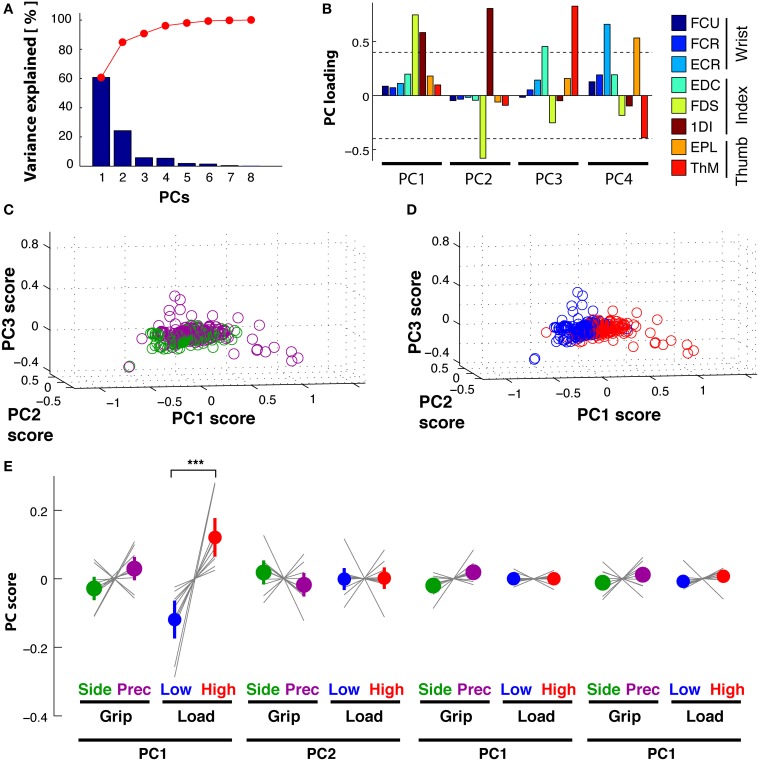
Hold period: PCA on EMG. (A) Scree plot: percentage of explained variance in the EMGs by each PC (blue bar, Eigenvalue in %) and cumulative percentage explained (red). (B) Loadings for each EMG (color-coded) per PC. (C) PC space formed by the first three PCs: each trial is represented by its PC scores. No visible separation between PC scores of side grip (green) vs. precision grip trials (purple). (D) PC space of the first three PCs: visible separation between PC scores of low (blue) vs. high (red) load trials on PC1. (E) Average PC scores (colored dot) and ±95% confidence interval (colored vertical bar) for each PC and task condition (thin gray lines correspond to the average scores for each subject). Significant difference in average PC scores on PC1 for LOAD (high vs. low).